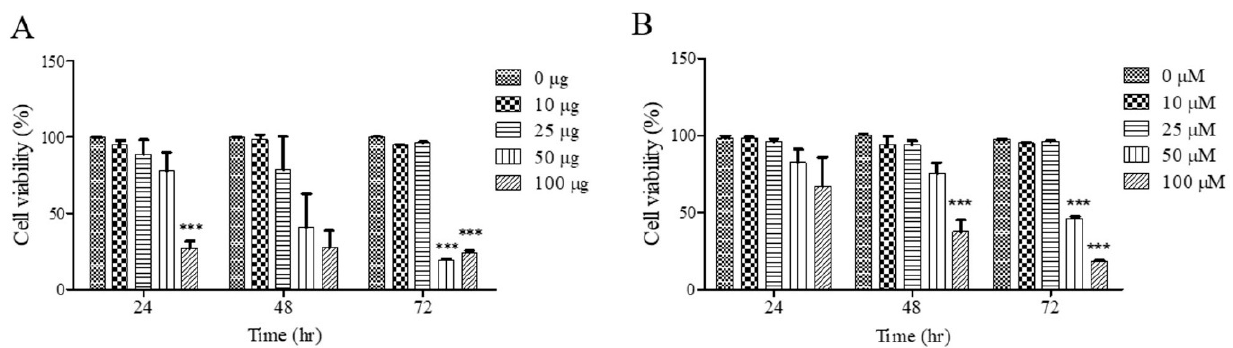
Figure 1. Effects of UF extract and UDCA on the viability of human FRO anaplastic thyroid cancer cells. The cells were treated with UF ( A ) or UDCA ( B ) at different concentrations for indicated time points. Cell viability was determined using the MTT assay. The data are presented as the mean ± SEM of three independent experiments. *** p < 0.05 vs. normal cells.